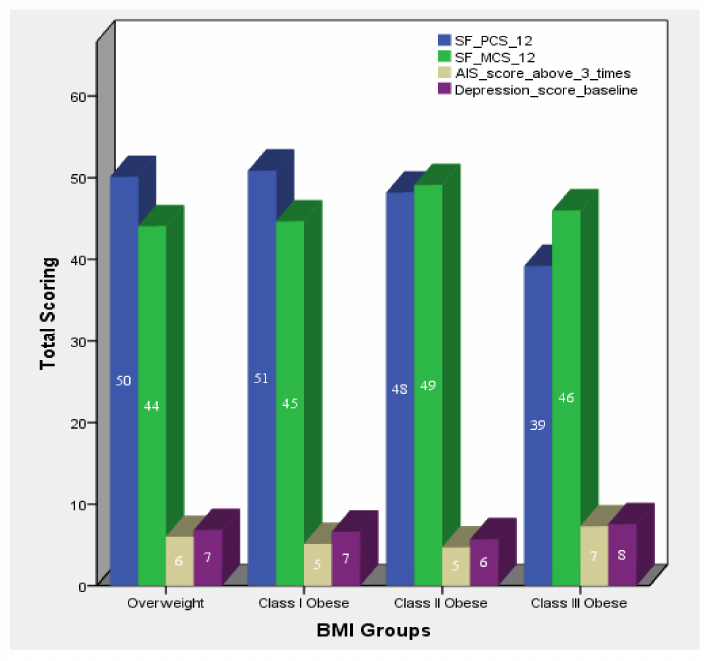
Figure 2. Baseline scoring of the four lifestyle questionnaires, based on BMI categories.